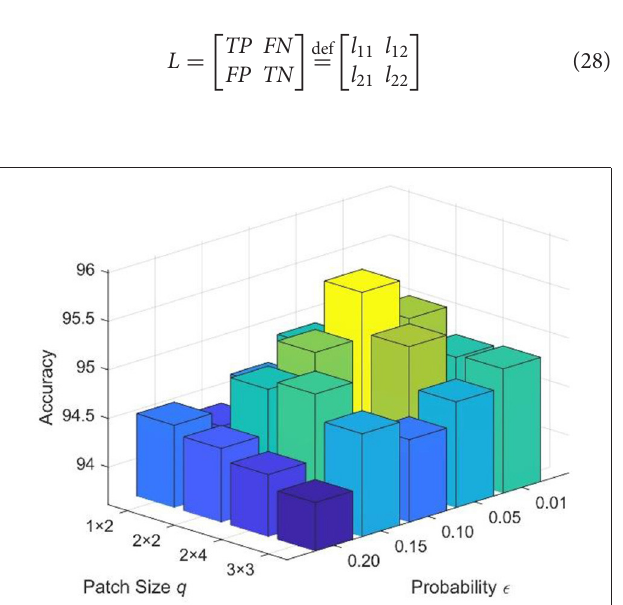
FIGURE 13 | 3D bar chart of micro-averaged F1 against q and ε .